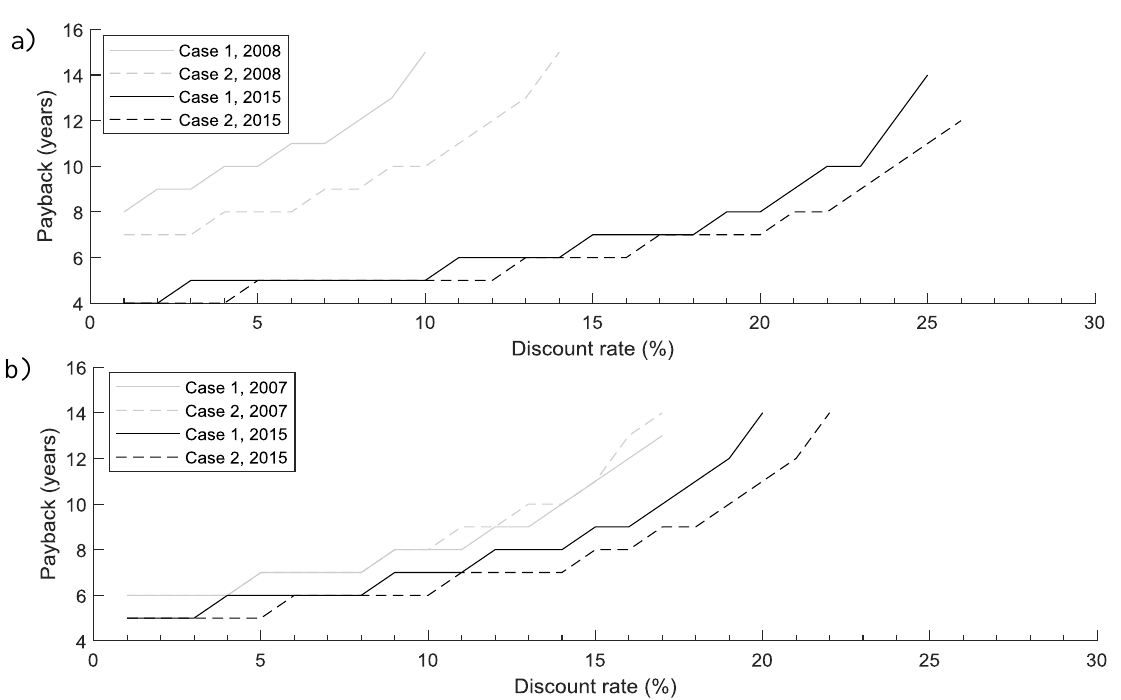
Figure 17. Payback period for several discount rates of the speed variable drive investment for WUA A ( a ) and WUA B ( b ).